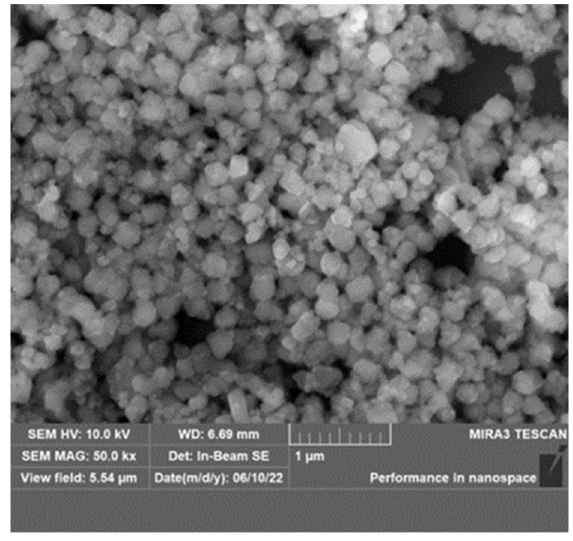
Figure 1. SEM image of the modified ZIF.